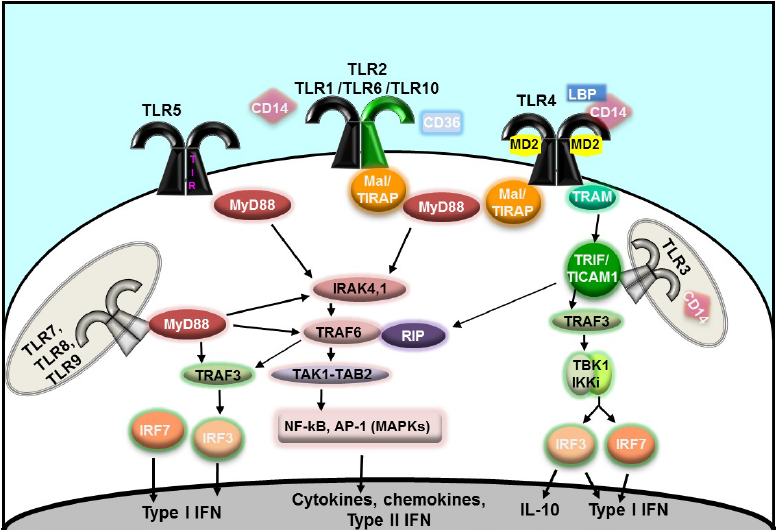
Figure 1. Schematic cartoon of Toll-like receptor (TLR) signaling [17,24,27–30]. Extracellular TLR homodimers (TLR4 and TLR5) are represented in black; heterodimers of TLR2 and TLR1, TLR6 or TLR10 are indicated in black/green. Intracellular homodimers (TLR3, TLR7, TLR8 and TLR9) are indicated in